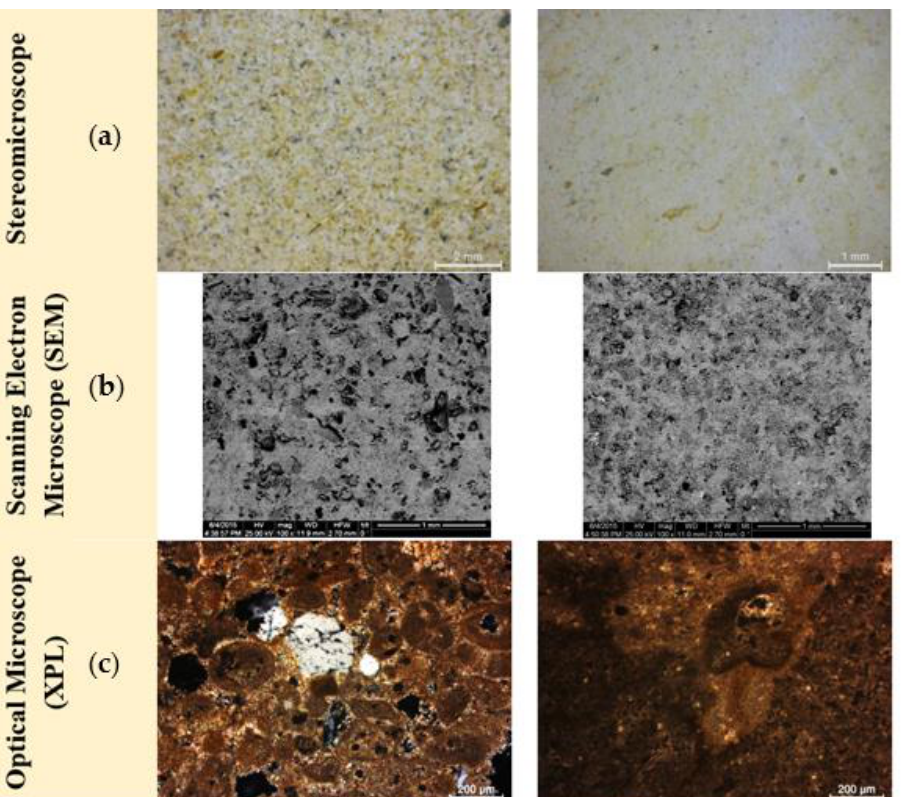
Figure 6. Microstructural and petrographic characteristics of representative samples from the seven untreated stone samples in ( a ) S_04 and S_05 in stereomicroscope (scale bar at 2 mm and 1 mm), ( b ) S_02 and S_07 in SEM microscope (BSE) (scale bar at 1 mm) and ( c ) S_04 and S_05 in optical microscope (XPL) (scale bar at 200 μm).